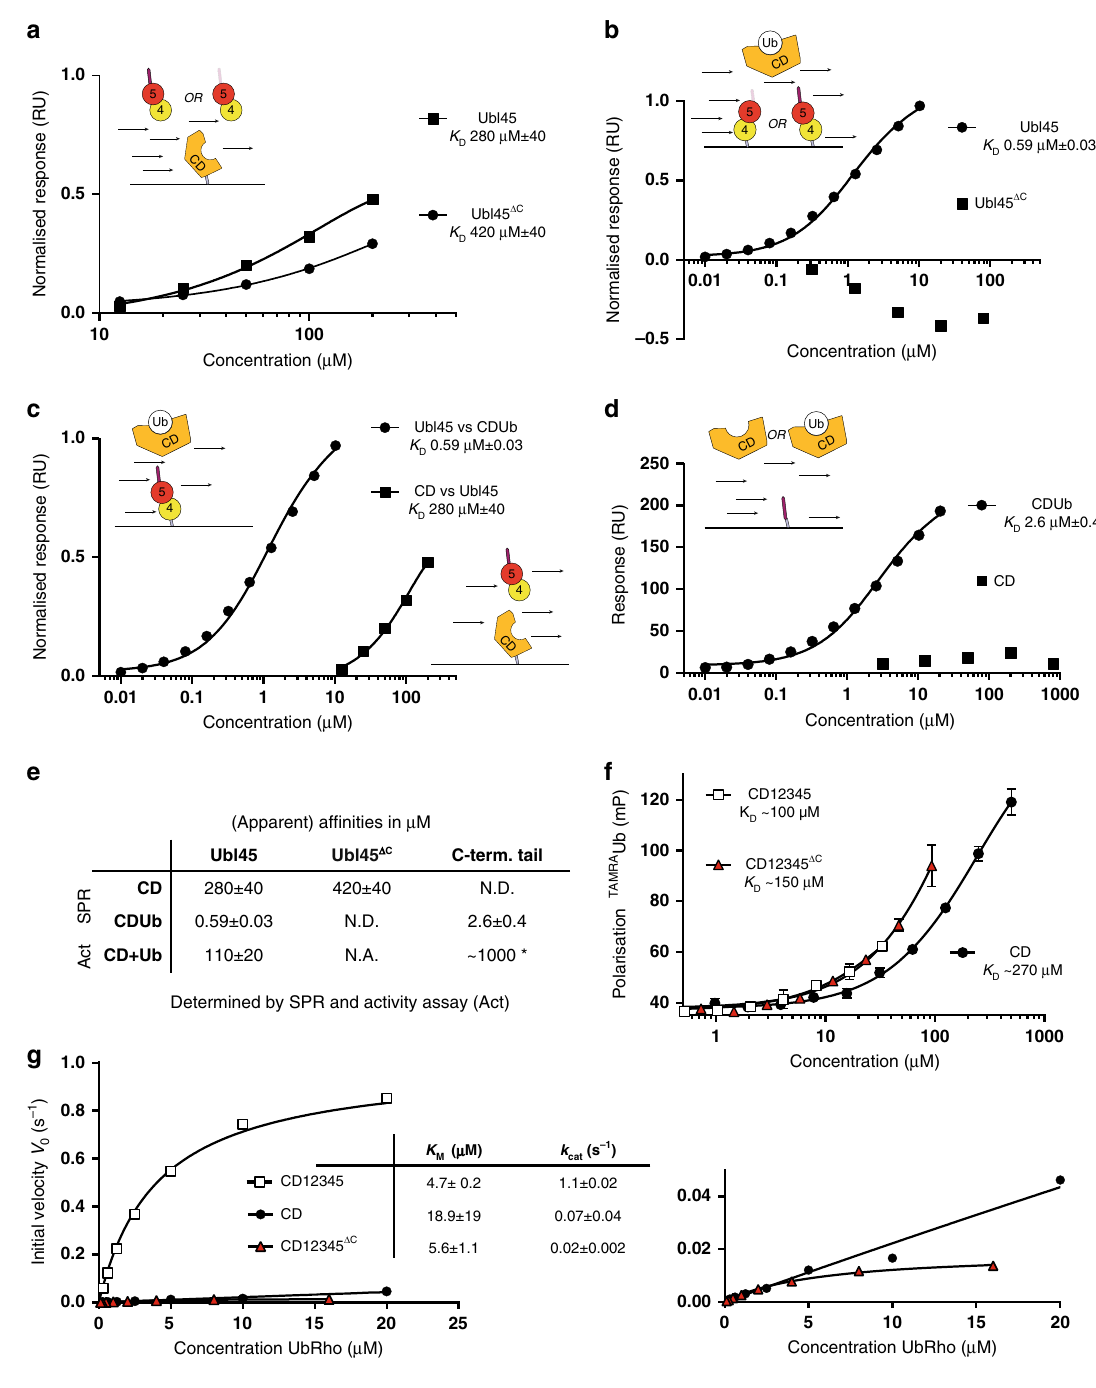
(Fig. 3e), we wondered if Ubl45 Δ C might affect the Ub binding. constructs (Fig. 3f). In this assay, we see the increased af fi nity Such an outcome is consistent with our previous results indi- for ubiquitin in the presence of the Ubl45 domain (when cating that in full-length USP7 self-activation increases the cat- comparing CD12345 with CD only) even when the tail is absent alytic rate ( k cat ) but also the K M (which is, on a minimal substrate, (comparing CD12345 Δ C to CD). The data indicate that the dominated by the af fi nity to ubiquitin), from >>35 µM to roughly presence of the C-terminal tail does not affect the CD af fi nity for 4 µM 31 . It may also explain why direct linkage of the C-terminal Ub, in line with its lack of af fi nity for CD observed in the NMR peptide to the CD almost, but not completely recapitulates the (Fig. 2b) and SPR experiments (Fig. 3d). full-length activity 36 . We could con fi rm the Ubl45-induced increase in af fi nity of CD for Ub by analysis of the steady-state kinetics of these constructs We therefore tested ubiquitin binding qualitatively in a fl uorescence polarization (FP) assay, following polarisation of in activity assays (Fig. 3g). When we fi t Michaelis-Menten curves for CD, CD12345 and CD12345 Δ C we could see that presence of TAMRA-labelled Ub upon incubation with various USP7 NATURE COMMUNICATIONS| (2019) 10:231